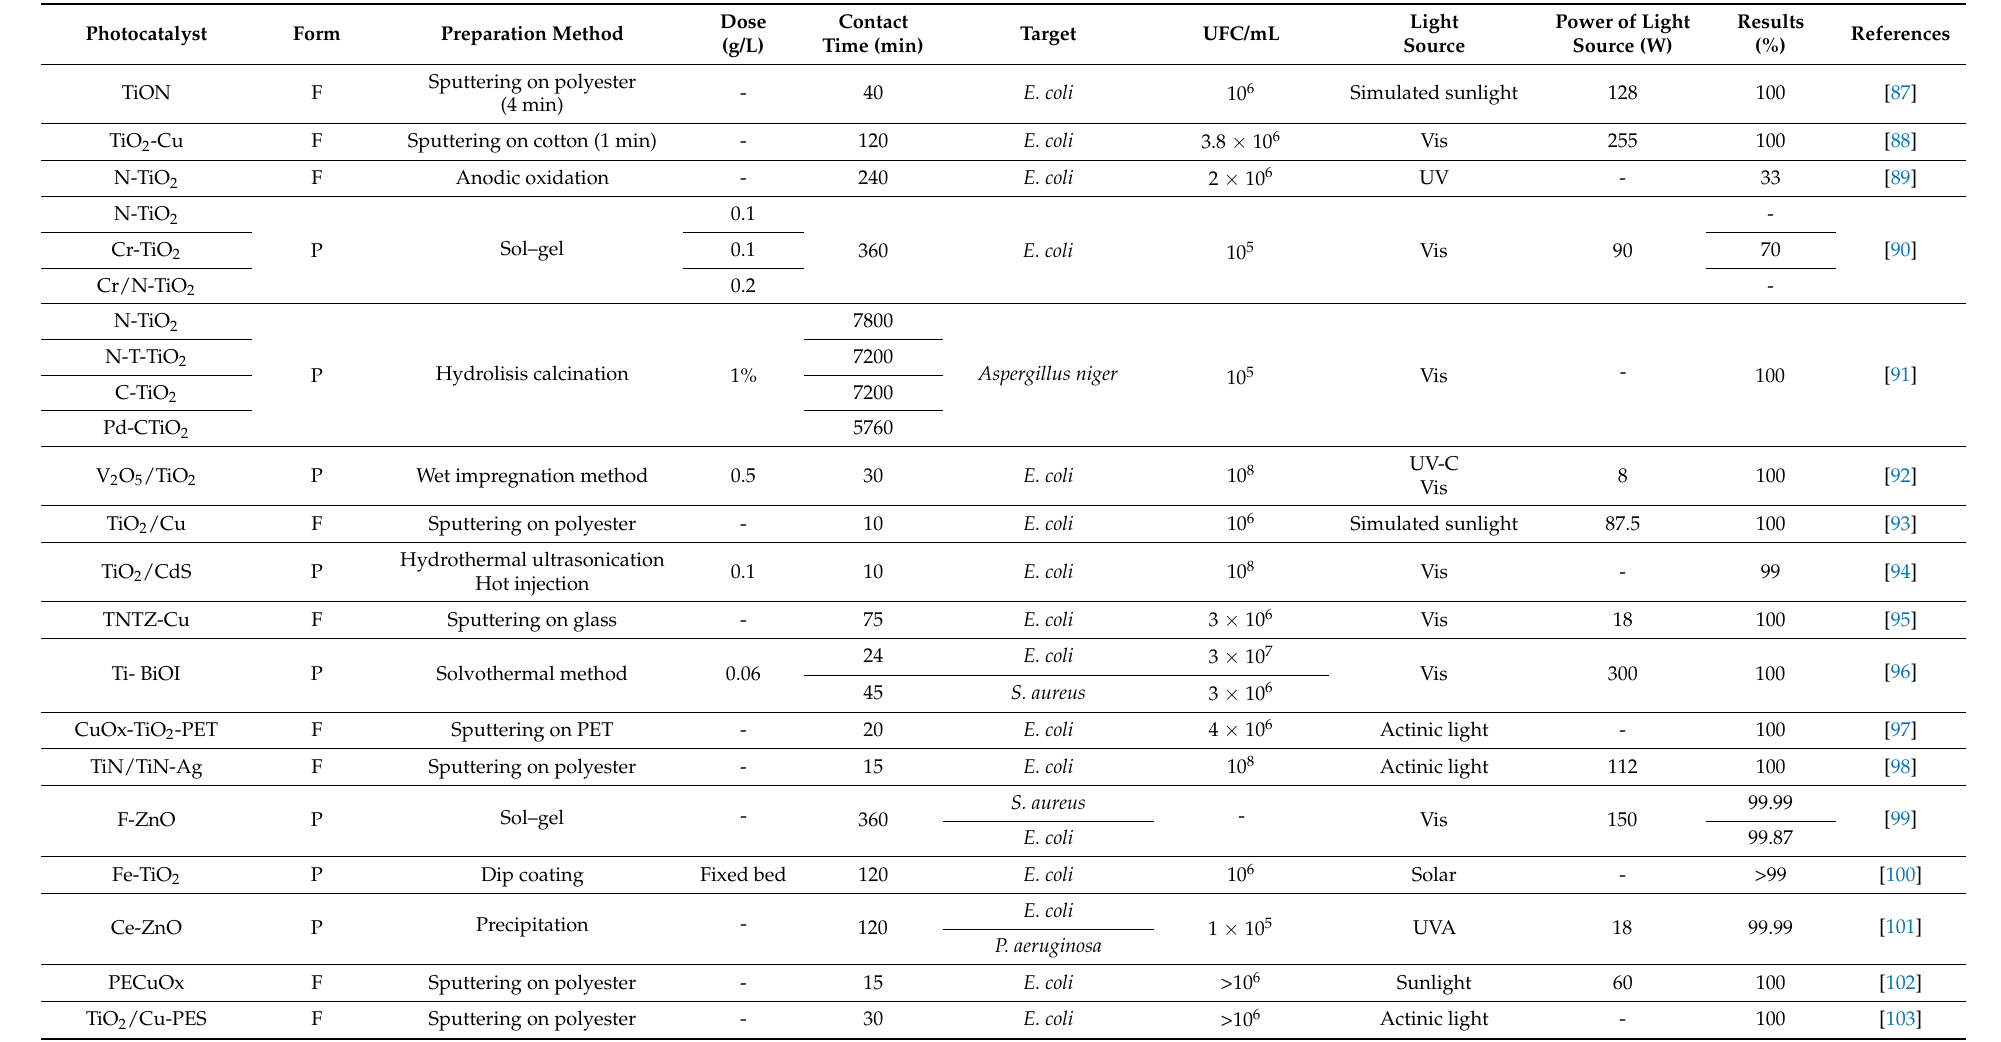
Table 2. Doped photocatalysts used for microorganism